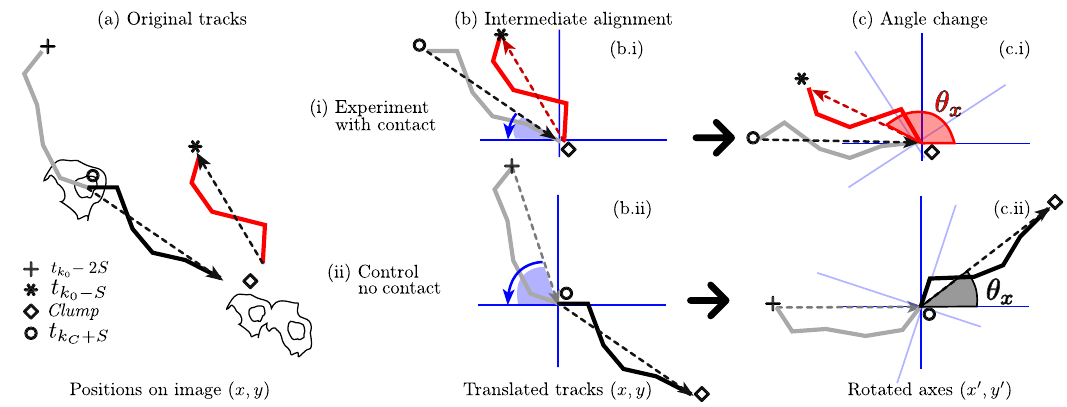
Figure 8. Measurement of angle change with cell–cell contact (i) and control (ii) experiments. Four markers are highlighted corresponding to specific time frames in each experiment. In order, the markers are: ( + ) 2 S frames before contact; ( ◦ ) S frames before contact; ( (cid:5) ) starting instant of the clump ; and ( ∗ ) S frames after the clump has finished. ( a ) Shows the original image with their original positions ( x , y ) ; ( b ) Shows the intermediate rotation of the tracks, where the tracks are rotated onto a common axis; ( c ) Represents the actual calculation of θ x . Trajectories show colours representing the portions of the tracks compared in contact (red) and control (black)